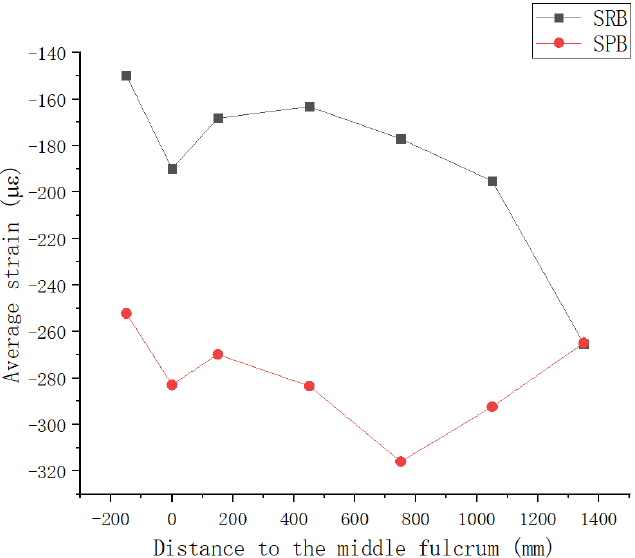
Figure 11. Longitudinal Distribution of Average Strain on Top of Concrete Deck at 7 Cross-Sections.